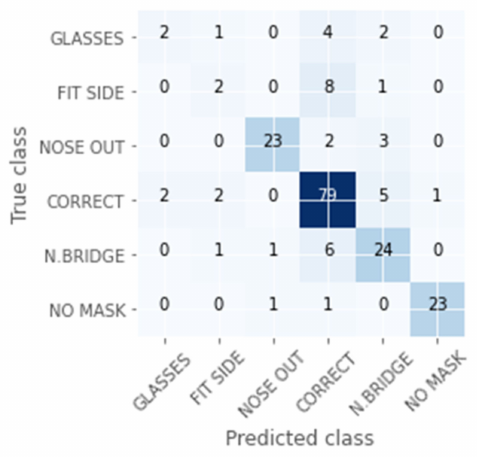
Figure 7. Confusion Matrix for CNN model in the validation